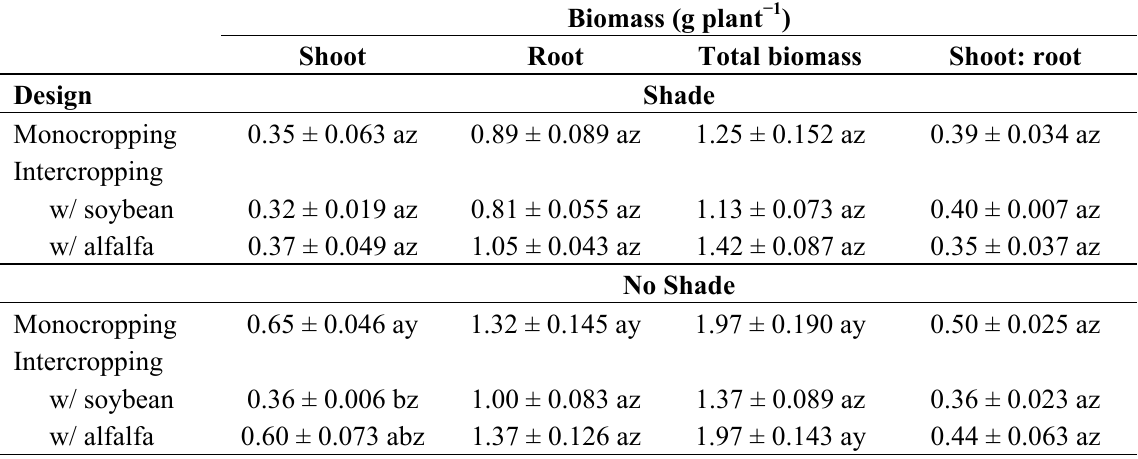
Table 1. Biomass means (±SE) for shoot and root tissue and shoot: root for monocropping and intercropped wheat under shade and no